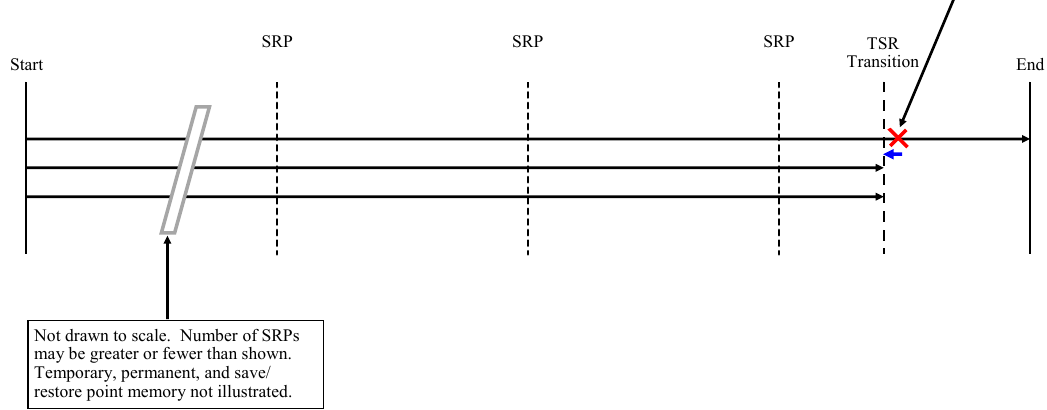
Figure A16. AHR MIPS TSR Best-Case Early Error Timing Diagram